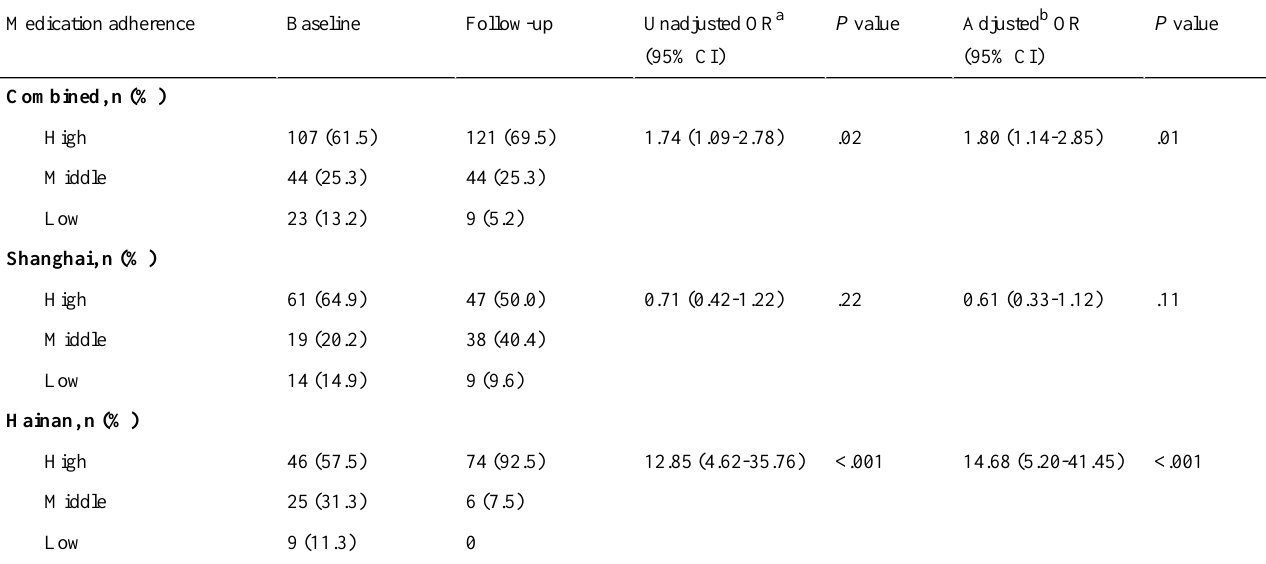
Table 2. Effect of the Adherence and Knowledge Exchange heart disease medicines (TAKEmeds) intervention on the primary outcome: medication